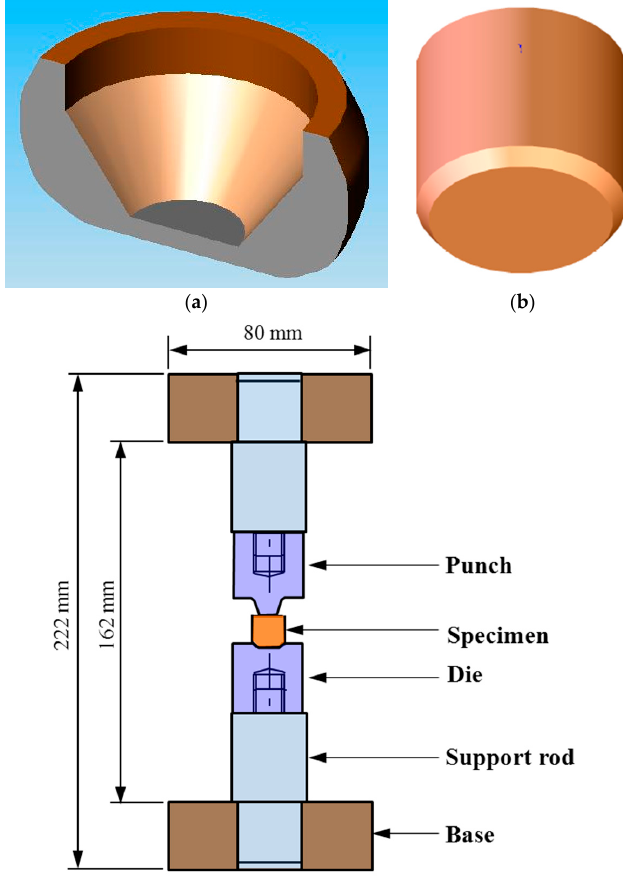
Figure 10. Sketches of ( a ) final cup shape (rib-web) of the component, ( b ) starting cylindrical specimen and ( c ) load train assembly for forging using servo-hydraulic machine [20].